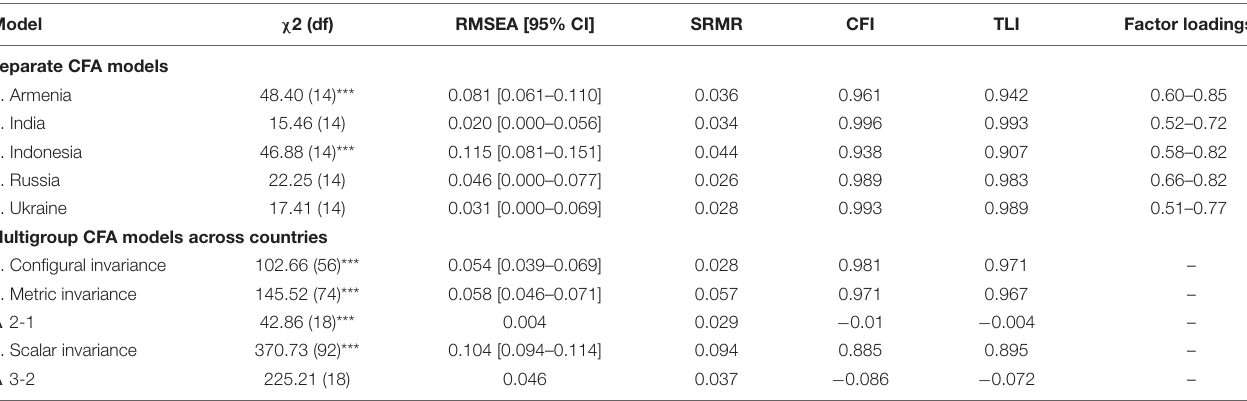
TABLE 2 | Separate and multigroup confirmatory factor analyses of the Short Home Attachment Scale across